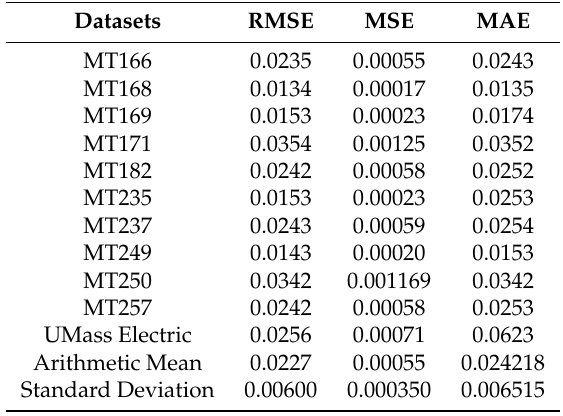
Table 22. Accuracy of ERELM using RMSE, MSE and MAE for half-yearly data.